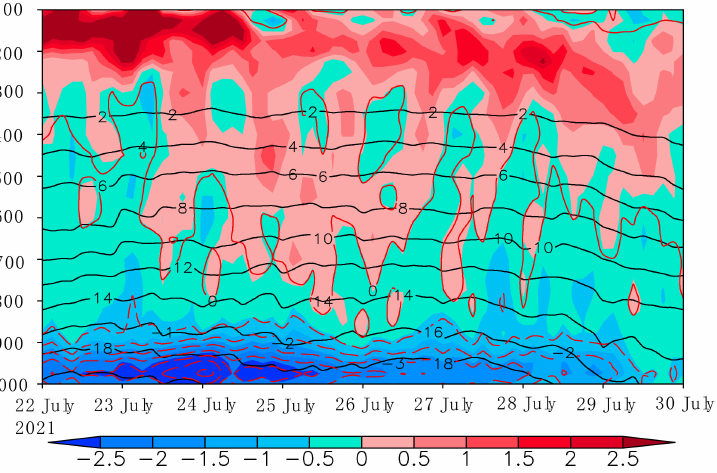
Figure 9. Vertical-time cross-section of typhoon circulation average divergence (shaded, unit: 10 − 6 s − 1 ), specific humidity (black line, unit: g kg − 1 ) and water vapor flux divergence (red dashed line, interval: 10 − 9 g cm − 2 hPa − 1 s − 1